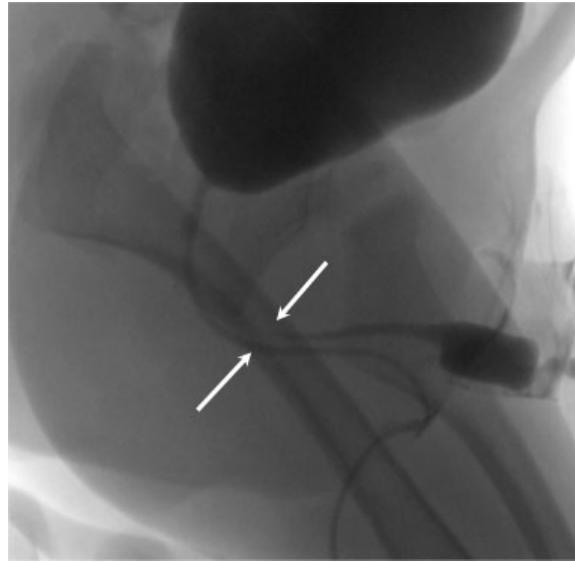
Fig. 3 A micturating cystourethrogram demonstrating a single distinct channel arising from the bladder, splitting into two